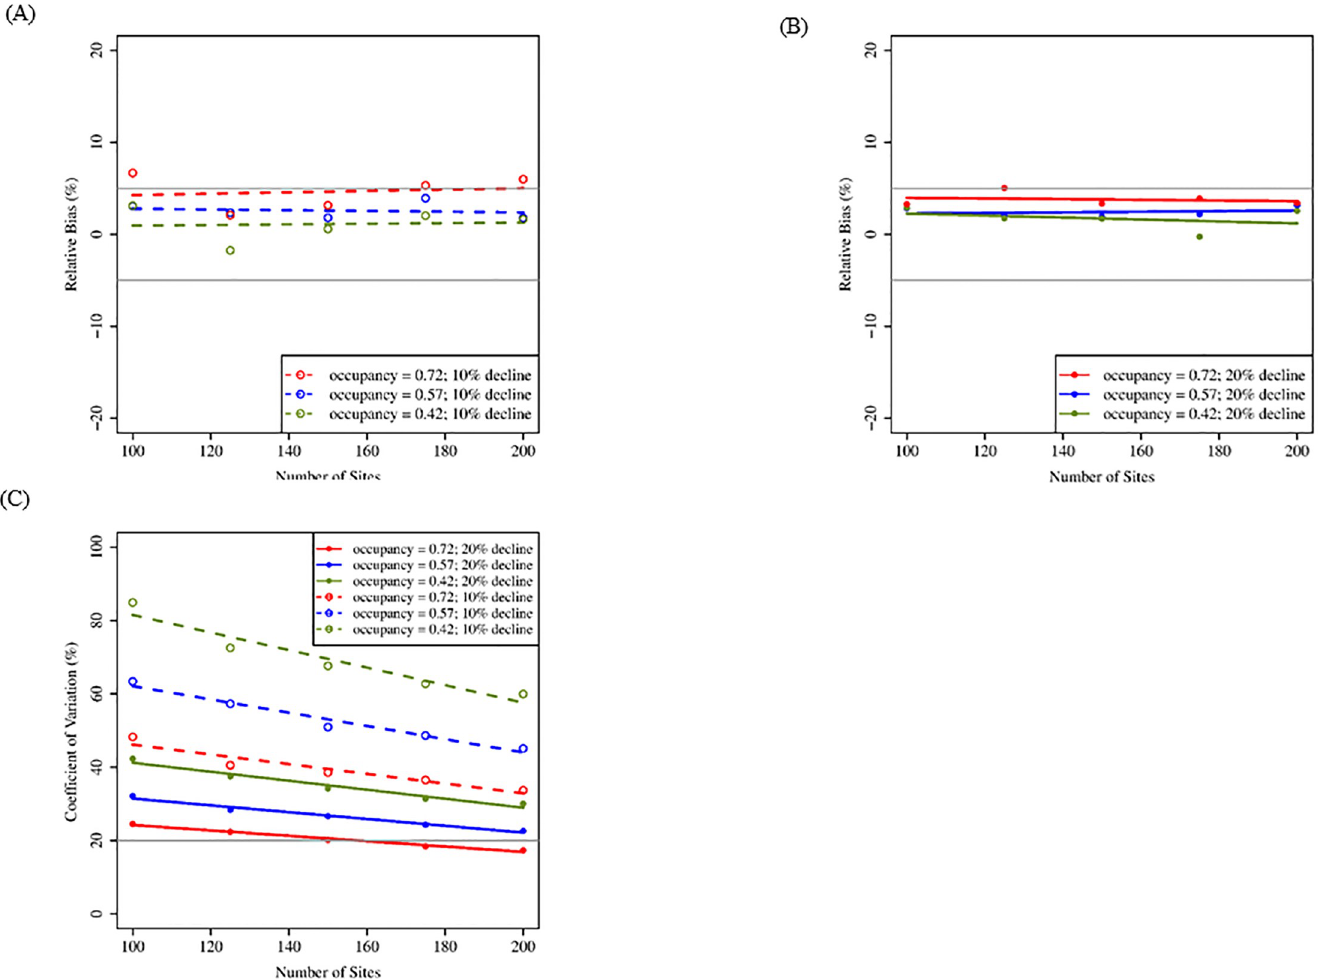
Fig 3. Mean relative bias and coefficient of variation for simulations increasing number of sites (standard design; 20 years). Mean relative bias (A: 10% decline; B: 20% decline) and coefficient of variation (C) for 100–200 sites, three initial occupancy rates, and two rates of population decline following a 20-yr monitoring period, assuming three visits and a probability of detection = 0.67. These results reflect a standard sampling design in which all territories are visited an equal number of times within a season. Gray lines indicate benchmark values for respective metrics (Table 2).